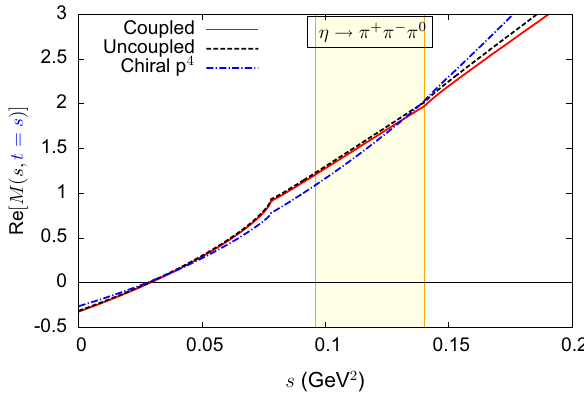
Fig. 7 Real part of the η → π + π − π 0 amplitude along the t = s line as a function of s . The yellow shaded area indicates the physical decay region. The lines are as in Fig. 5